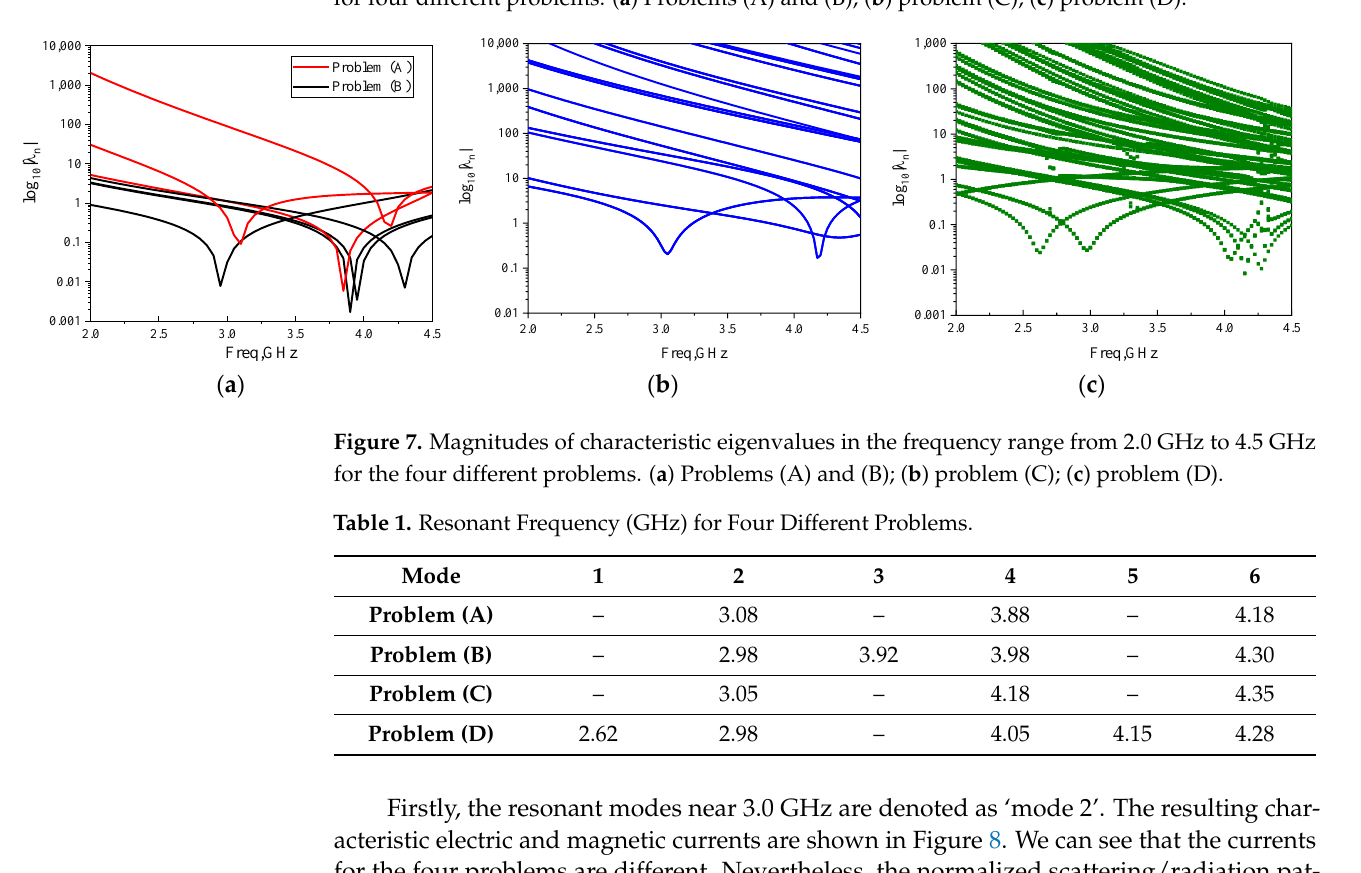
Figure 6. The real parts of characteristic eigenvalues with frequency range from 2.0 GHz to 4.5 GHz for four different problems. ( a ) Problems (A) and (B); ( b ) problem (C); ( c ) problem (D).